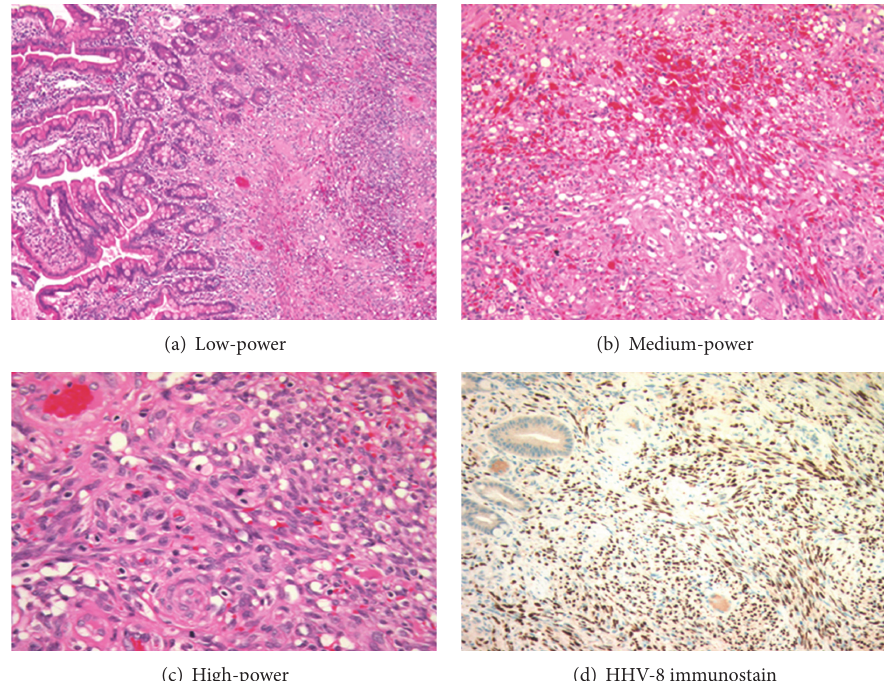
Figure 2: (a) Histologic section of small bowel (H&E). On the left, this low-power view shows normal intestinal villi protruding into the bowel lumen. On the right, beneath the villi, is a disorganized spindle-cell lesion. (b) Histologic section of small bowel (H&E). Extravasated blood is a prominent feature within the spindle-cell lesion, in this medium-power view. (c) Histologic section of small bowel (H&E). Small spaces, sometimes slit-like, are present within the spindle-cell proliferation. Mitotic activity is readily identified. (d) Histologic section of small bowel (HHV-8 immunostain). There is strong nuclear staining of the tumour